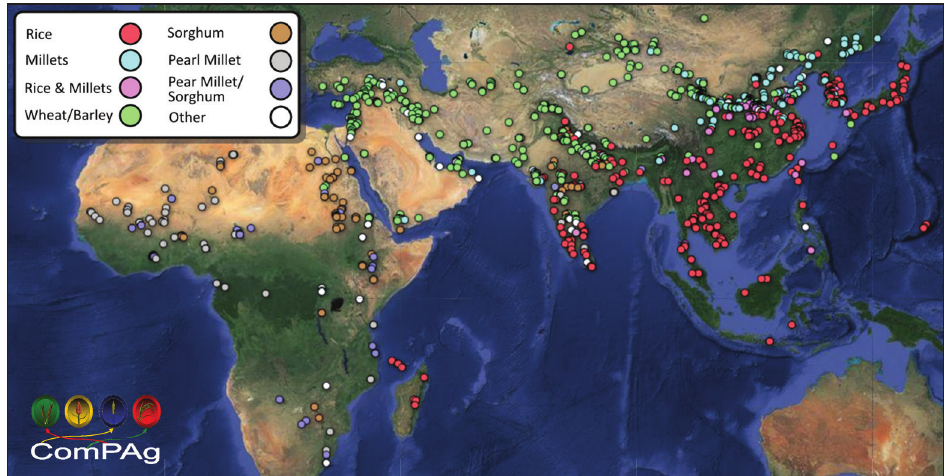
Figure 1: Map of sites with archaeobotanical evidence in Asia and Africa compiled into a database as part of the ComPAg project. This illustrates the geographical range of different early crops and gaps in current